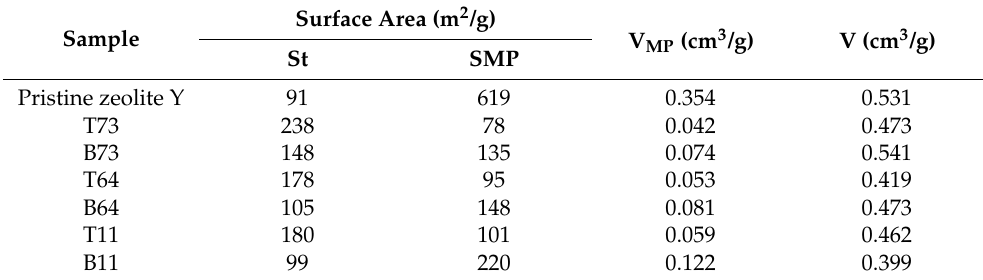
Table 3. Surface area and pore volume of parent zeolite Y and ball-milled